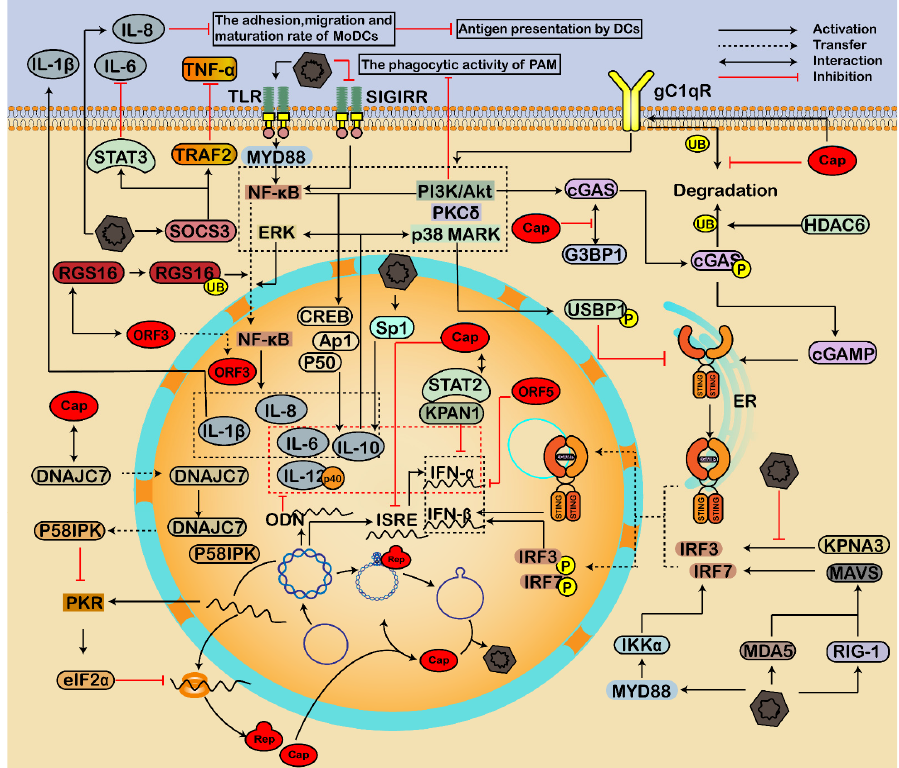
Figure 4. Immune response and inflammatory reactions regulated by the interaction of PCV and host factors. PCV infection can not only activate the production of IFNs but also inhibit IFNs, forming complex crosstalks between host proteins and PCV2, leading to immunosuppression and persistent infection. During infection, the viral Cap inhibits ubiquitin-mediated proteasomal degradation of cellular C1QBP (gC1qR), thus enhancing the phagocytic activity through the PI3K pathway. The interaction of viral Cap and host C1QBP also promotes phosphorylation of cGAS via PI3K/Akt and PKC δ signal pathways, leading to the release of cGAMP, dimerization, and translocation of STING into the nucleus, and thus an enhancement of type I IFN production. Additionally, PCV2 activates RIG-1/MDA-5/MAVS/IRFs and MyD88-IKK α -IRFs pathways to enhance the type I IFN responses. On the contrary, HDAC6 mediates the ubiquitination of cGAS to degrade cGAS in autolysosomes. Furthermore, PCV blocks the nuclear translocation of p-IRF3 by destroying the interaction between KPNA and p-IRF3 and inactivating STING through the p38-MAPK pathway, thus inhibiting the induction of type I IFN. Moreover, PCV modulates inflammatory responses through PI3K/Akt, p38 MAPK, and NF- κ B pathways to inhibit antiviral responses and the maturation of immune cells. Activation of the NF- κ B pathway is critical for inflammatory reactions during PCV infection. The interaction between viral Cap and host C1QBP induces the activation of PI3K/Akt and p38 MAPK signals, thus enhancing the production of IL-10. In addition, PCV2 induces IL-8, IL-1 β , and IL-10 via the TLR/MyD88/NF- κ B signaling pathway. Moreover, the RGS16 interacts with viral ORF3 protein and participates in the nuclear transport of the ORF3. However, the interaction between virus ORF3 and RGS16 in the cytoplasm also causes ubiquitination and proteasomal degradation of RGS16, which further enhances nuclear entry of NF- κ B through the ERK1/2 signaling pathway and increases IL-6 and IL-8. On the contrary, PCV2 enhances the interaction of the SOCS3 and STAT3/TRAF2, resulting in the downregulation of secreted IL-6 and TNF- α signaling, further decreasing the maturation of MoDCs and antigen presentation by DCs. The PKR signaling pathway activates eIF2 α to inhibit virus protein. However, the viral cap can interact with DNAJC7 to inhibit the activation of